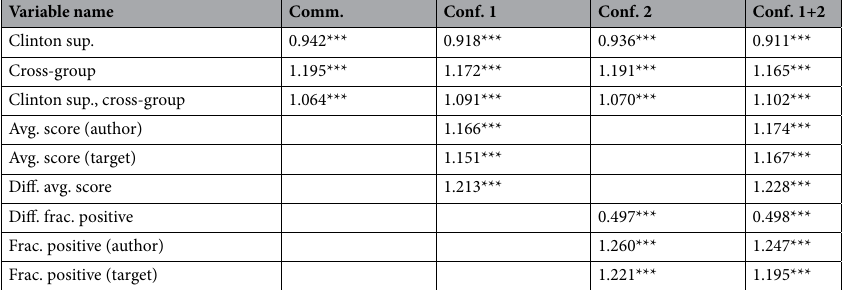
Table 2. Odds ratios obtained by logistic regression. Each column corresponds to a model with a specific set of variables: we have community features in the first column; then, we add to the model the first, the second, and both sets of confounding variables. All the variables shown here have a statistically significant ( p < 0.001 ) impact on the likelihood of writing a comment. * p < 0.05 , *** p < 0.001